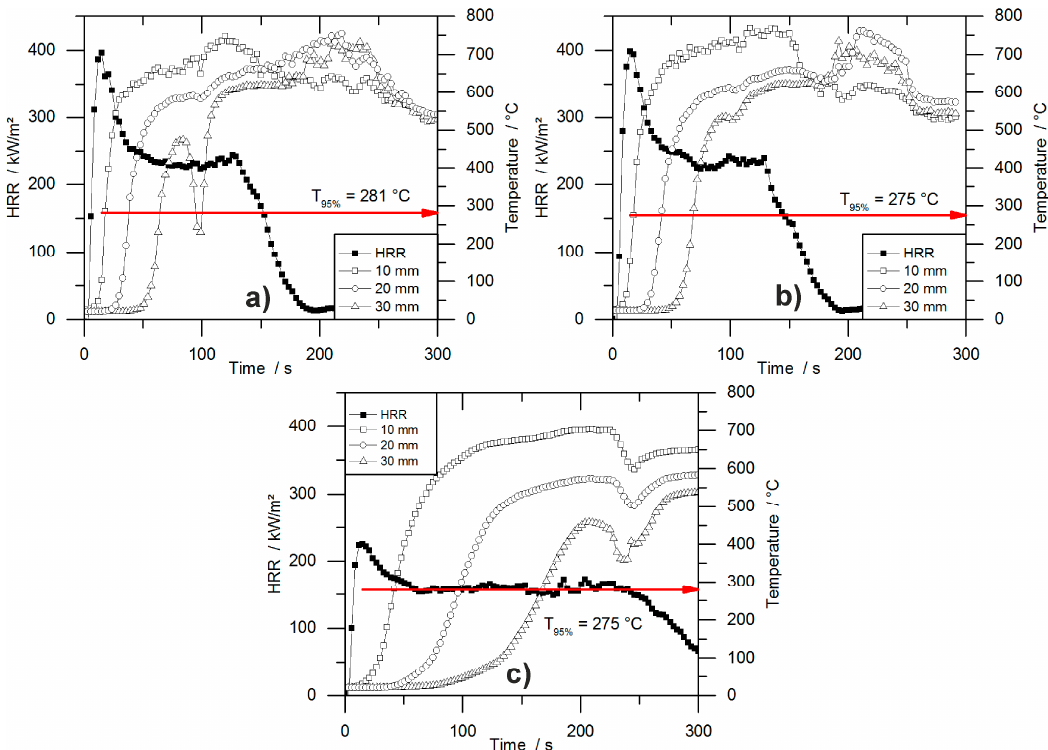
Figure 7. Heat release rate curve and temperature development inside a burning specimen of ( a ) PUR-50-P ( b ) PUR-50-H, and ( c ) PIR-50-P.